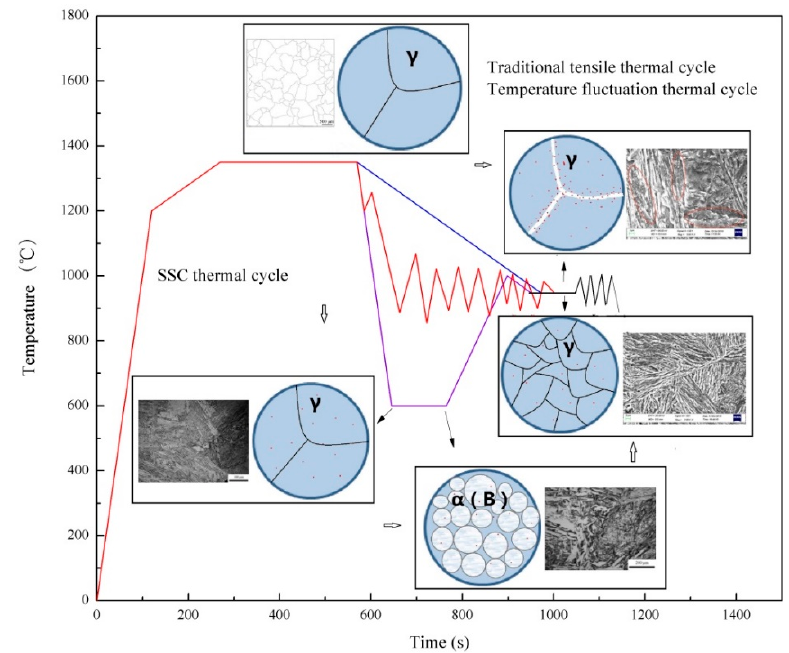
Figure 17. Schematic diagram of the effect of different thermal schedules on ductility.